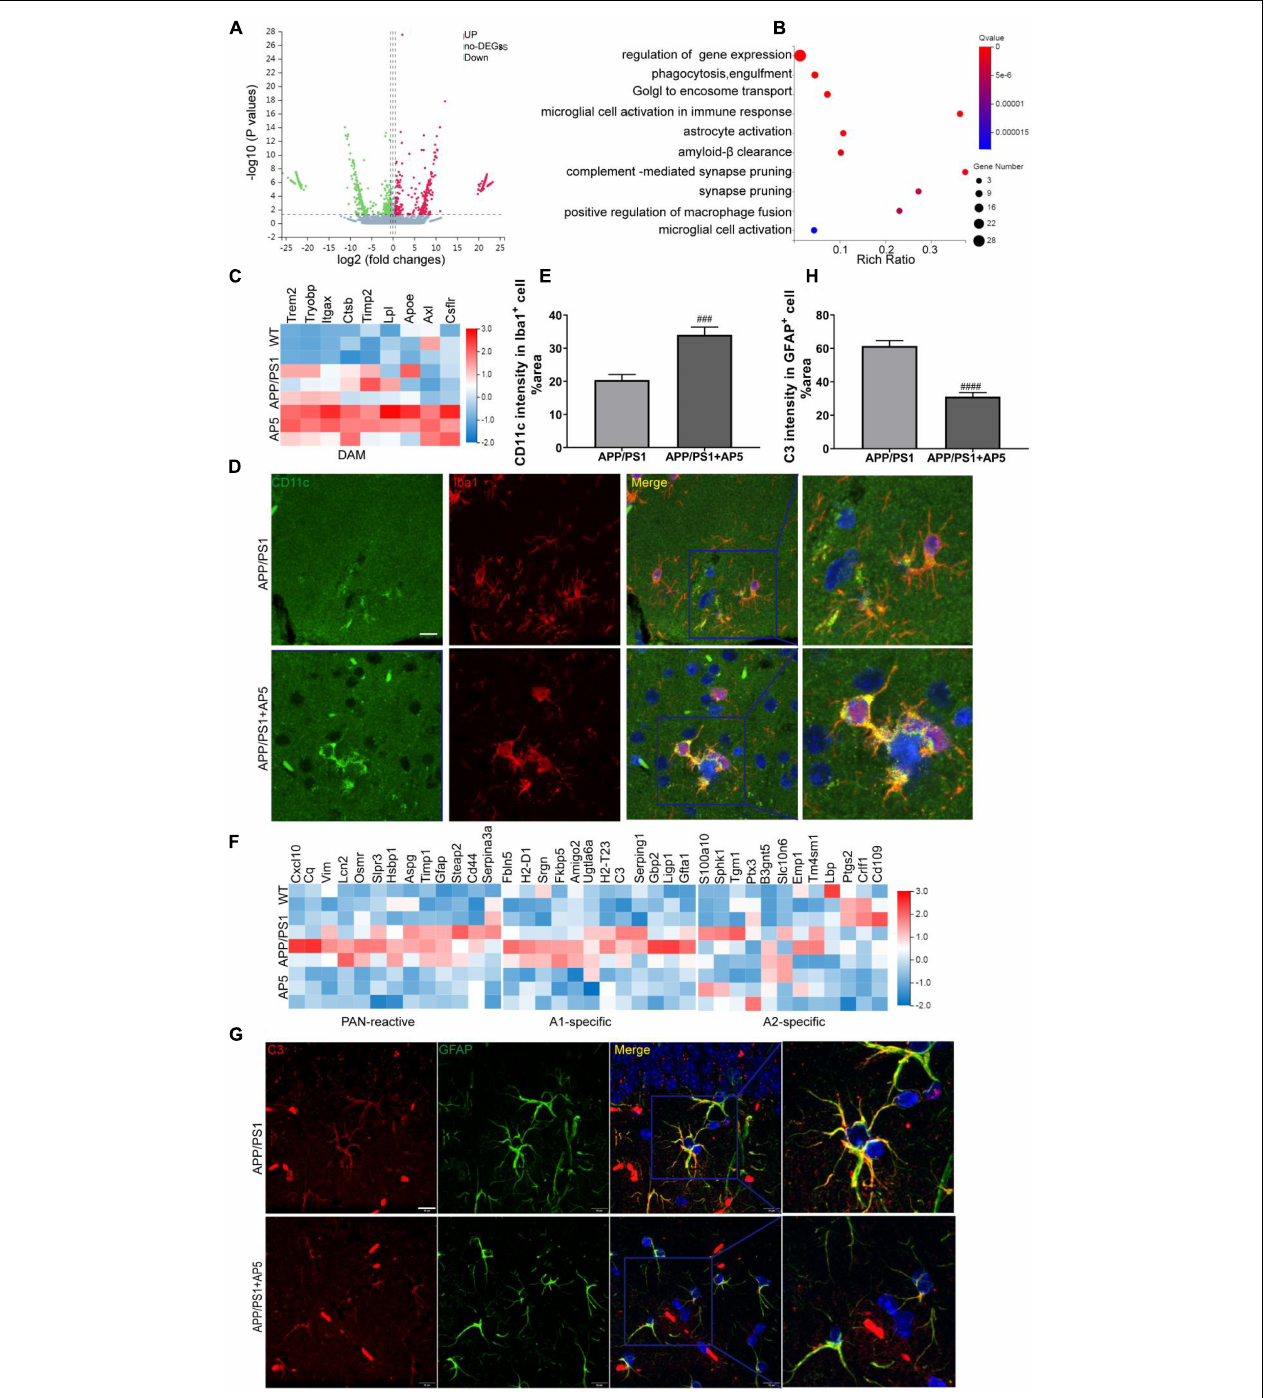
FIGURE 6 | Transcriptomic profiling overview of hippocampi from WT, APP/PS1, and AP5 mice. (A) Volcano plots show the differentially expressed mRNAs in the hippocampus of AP5 vs. APP/PS mice. (Vertical lines represent ≥ 1.5-fold changes, and the horizontal line represents p < 0.05). (B) Gene ontology(GO) annotation of differentially expressed mRNAs in the hippocampus of AP51 vs. APP/PS mice. The top 10 GO terms are shown. (C) Hierarchical clustering heatmap of DAM genes from RNA-seq in hippocampus among WT, APP/PS1, and AP5 mice. (D) Representative images of CD11c, a DAM marker, and Iba1 co-immunostaining and (E) quantification of CD11c area within microglia from APP/PS1 and AP5 mice. Cell nuclei are shown in blue (DAPI). Scale bar:10 µ m. (F) Hierarchical clustering heatmap of reactive astrocyte genes from RNA-seq in hippocampus among WT, APP/PS1, and AP5 mice. (G) Representative images of C3, A1 astrocyte marker, and GFAP co-immunostaining and (H) quantification of C3 area within astrocyte from APP/PS1 and AP5 mice. Scale bar:10 µ m. ### P < 0.001, #### P < 0.001 compared with APP/PS1 mice by unpaired t -test, n = 6 mice per group.